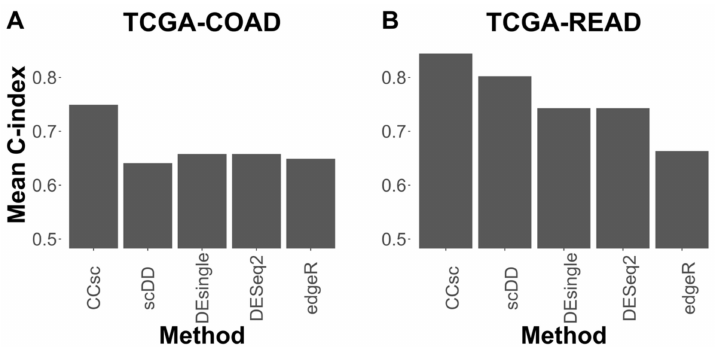
Figure 3. CCsc MMS Outperforms Other Methods. ( A ) We tested CCsc against several well- established tools on the TCGA-COAD dataset. We compared the mean concordance index per- formance of CCsc with its ideal weighting to DESeq2, edgeR, scDD, and DEsingle. We gave each method its optimal number of genes and ran each with its recommended settings, according to their respective best practices. ( B ) Same comparison but on the TCGA-READ dataset. We show that CCsc outperforms single-cell methods (scDD and DEsingle) and that bulk RNA-seq methods can be optimized for single-cell RNA-seq data (DESeq2, edgeR).